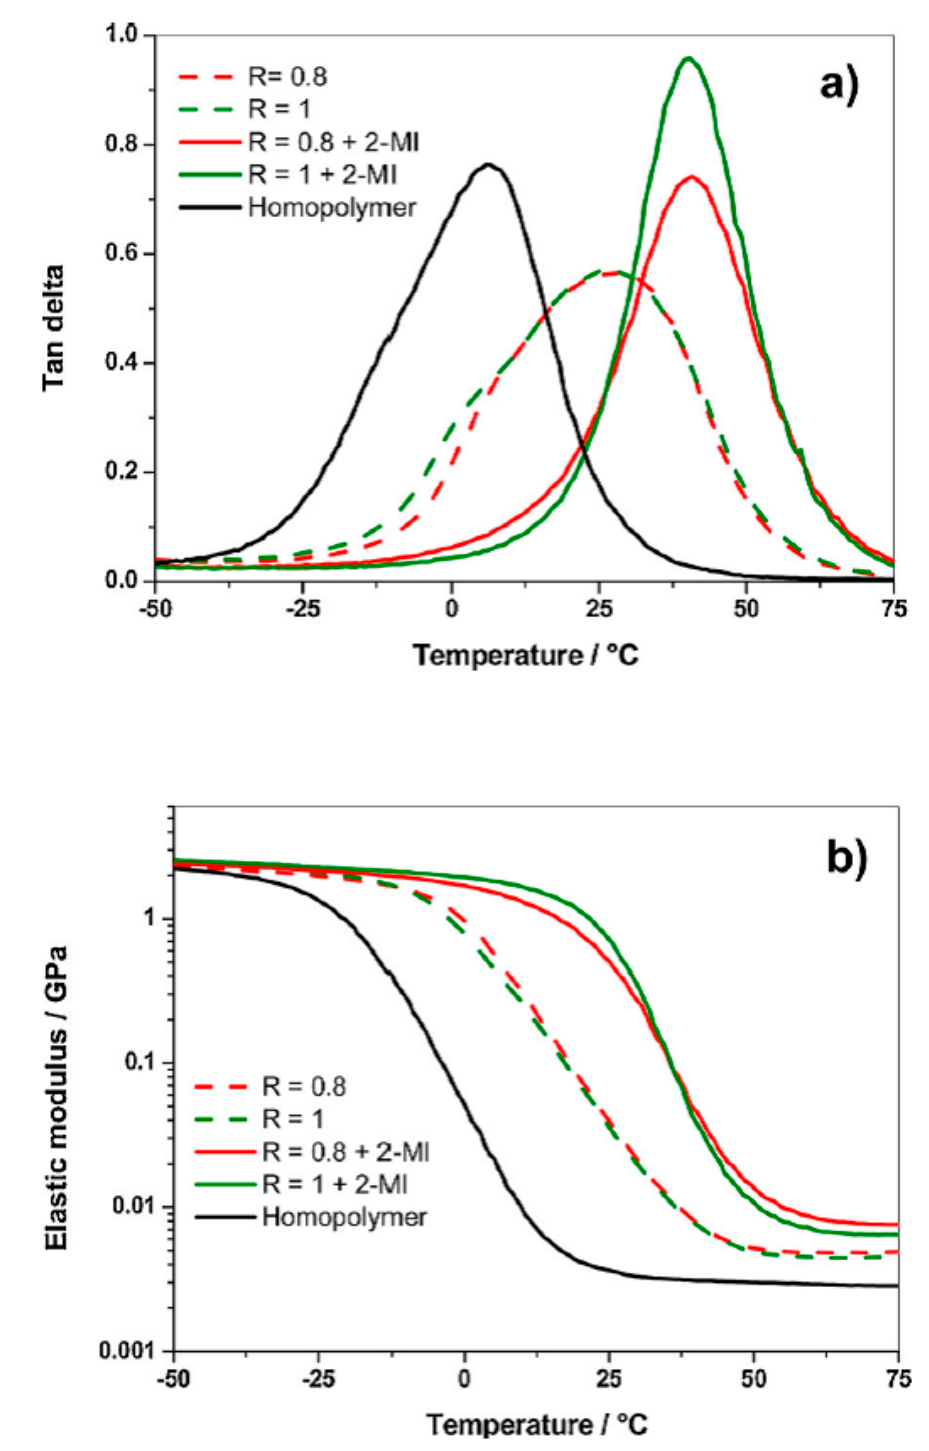
Figure 2. ( a ) tan delta curves and ( b ) elastic modulus vs. temperature from − 50 ◦ C to 75 ◦ C of cured Epoxidized Linseed Oil (ELO)/bio-based dicarboxylic acid at different ratio (R) with 2- methylimidazole (2-MI). Reprinted from [4] with permission of